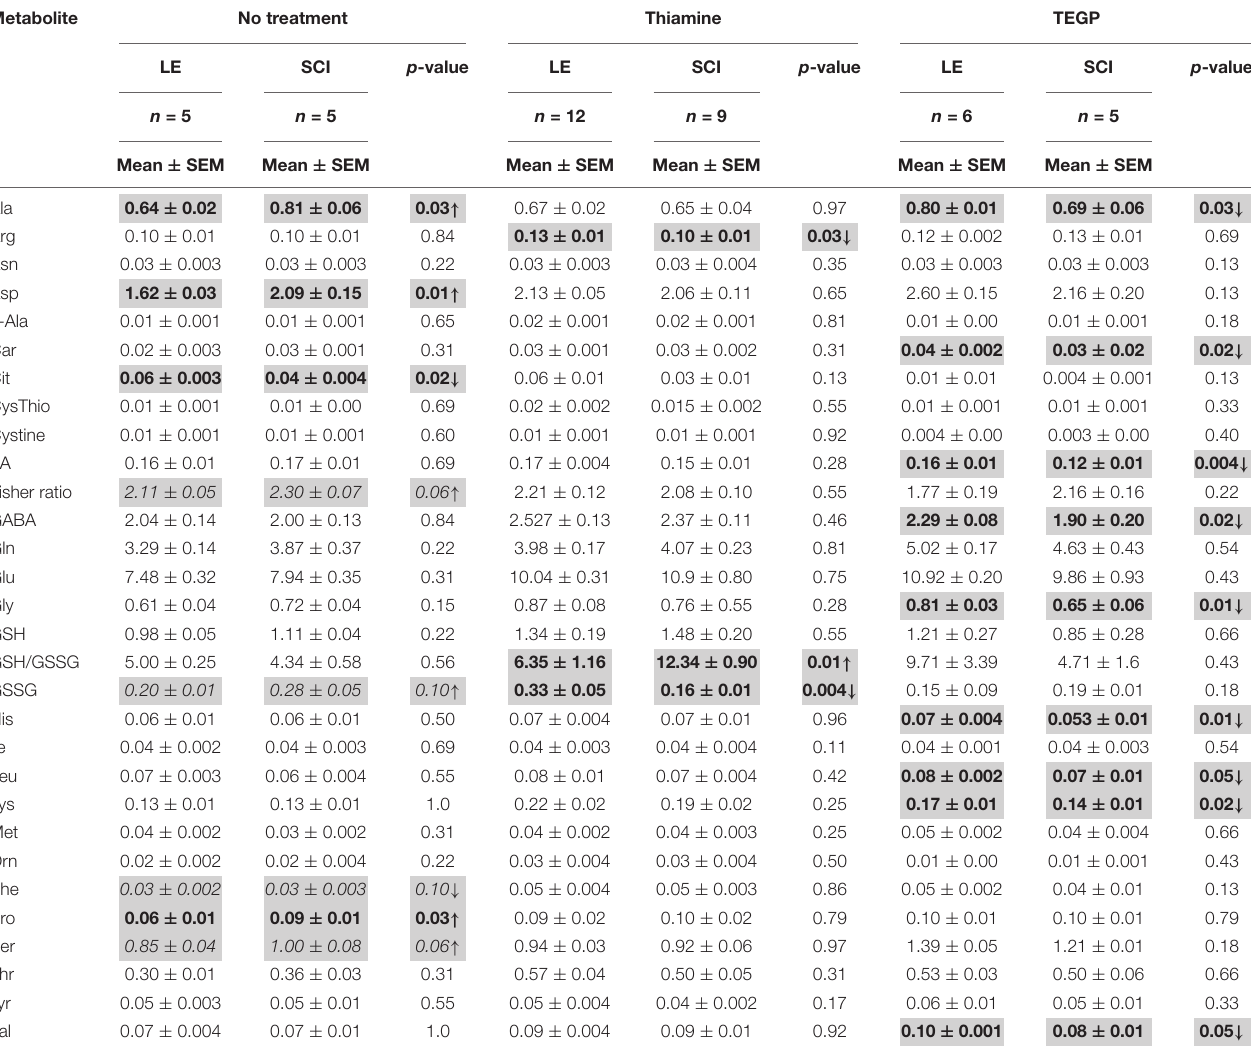
TABLE 1 | Metabolic profiling of free amino acids and related compounds in the brain cortex of the rats subjected to laminectomy (LE) or severe spinal cord injury (SCI), non-treated or after administration of thiamine or TEGP. Metabolite No treatment Thiamine